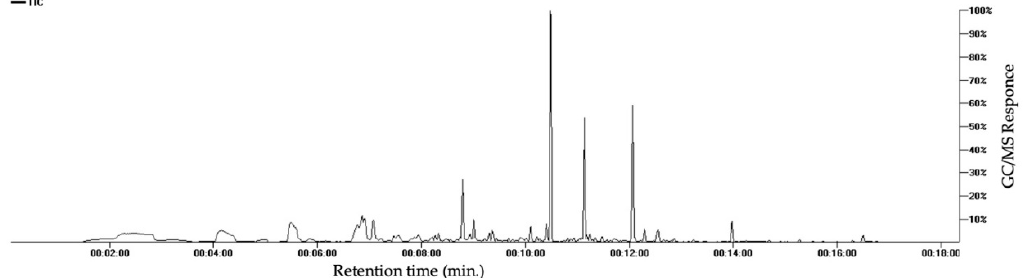
Figure 6. Representative SPME-GC-MS chromatogram of L. sativum .